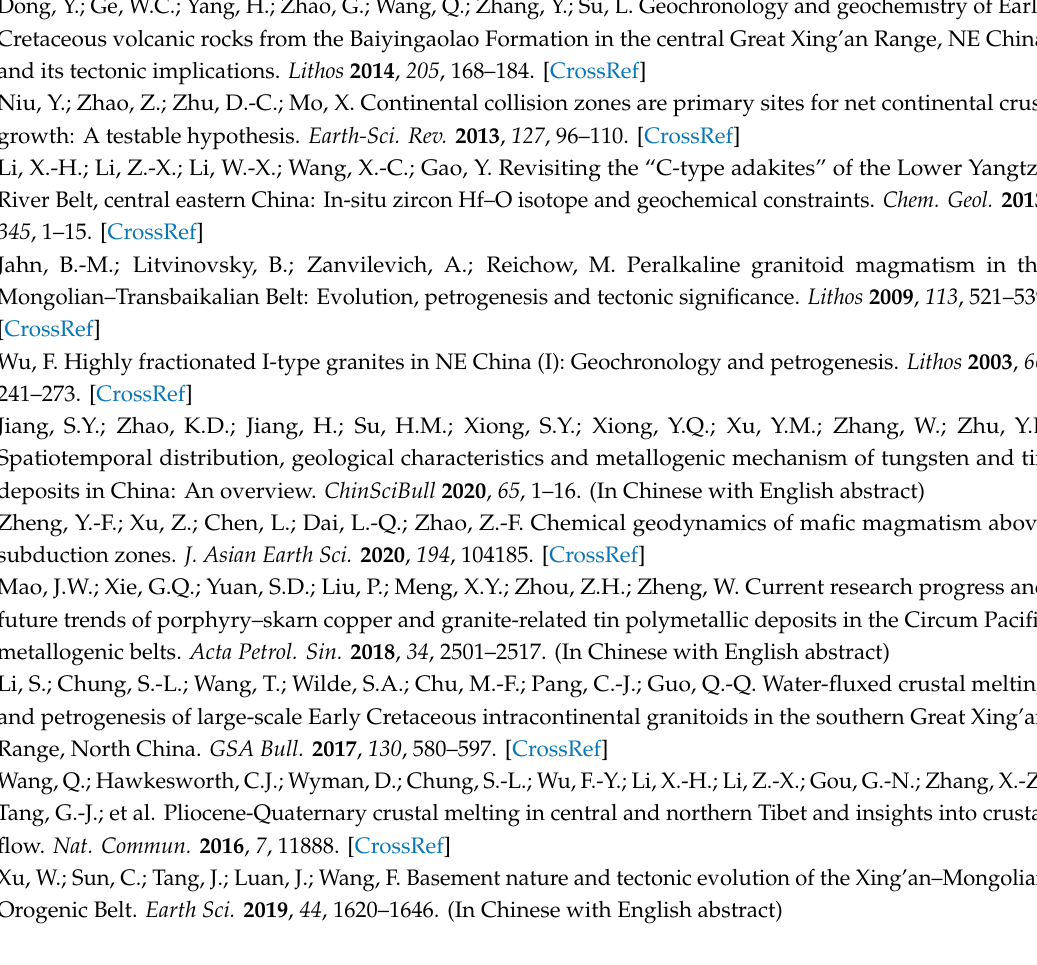
Table S1: SHRIMP zircon U–Pb age data for granitoids from Zalute in the SGXR, Table S2: Hf isotopic data for granitoids from Zalute in the SGXR, Table S3: Major (wt.%) and trace element (ppm) compositions of granitoids from Zalute in the SGXR, Table S4: Whole-rock Sr–Nd isotopic compositions for granitoids from Zalute in the